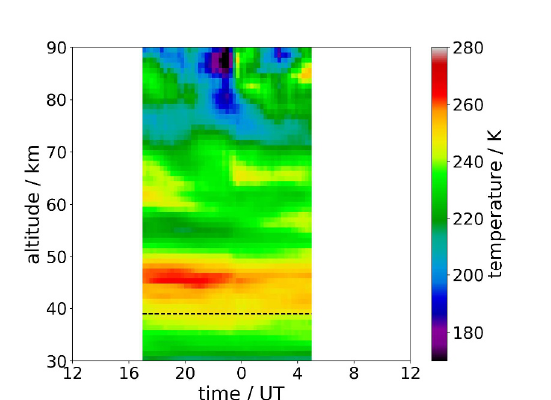
Fig. 4: Temperature observations with the RMR lidar at Kuehlungsborn. Data are limited to nighttime to cover also the upper mesosphere. Integration time is 2 h. The dashed line denotes transition of height channels.